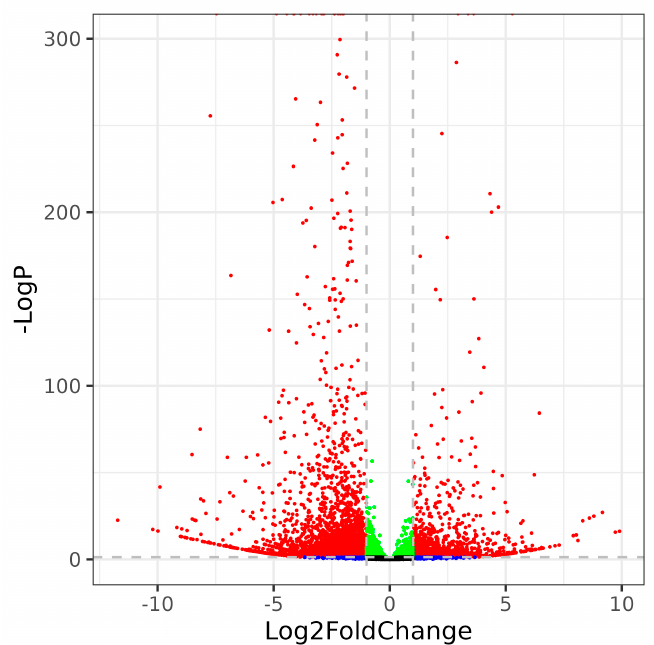
Figure 2. Distribution of DEGs in rice under heat stress. Red dots represent genes with |log2FC| ≥ 1 and p -value ≤ 0.05, green dots represent genes with |log2FC| < 1 and p -value < 0.05, blue dots represent genes with |log2FC|>1 and p -value > 0.05, and black dots for genes with no obvious statistical significance.